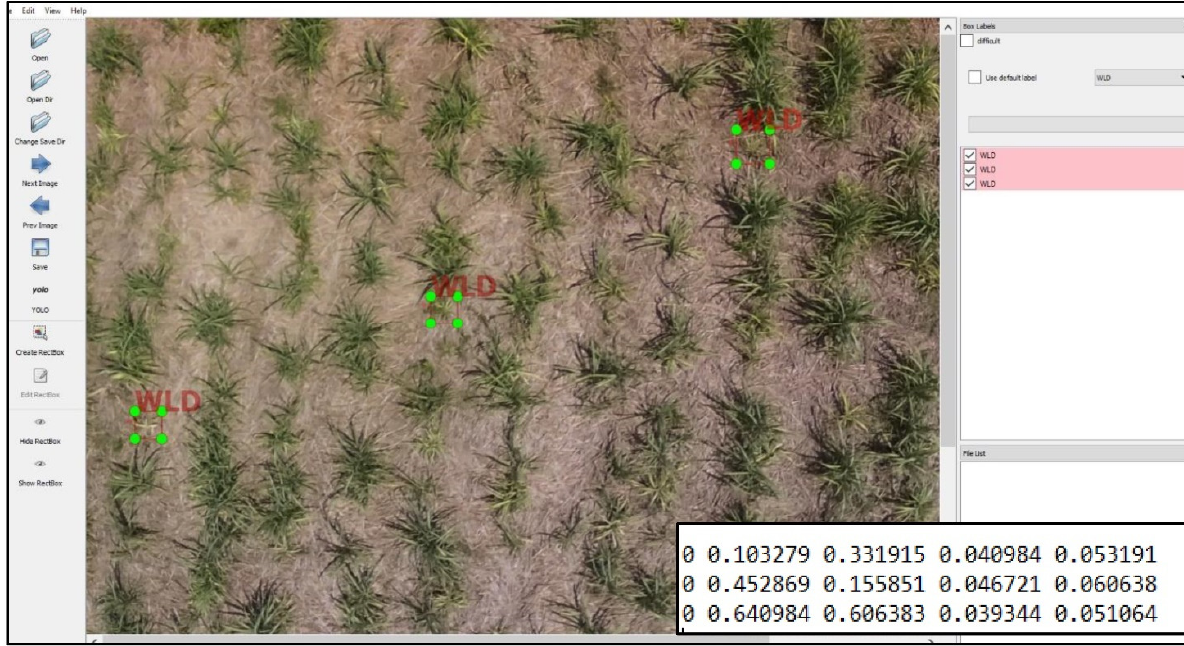
Figure 4. Manual labelling of plants with WLD from UAV imagery using